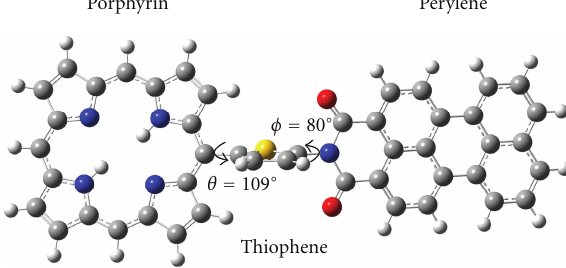
Figure 2: The optimal structure of the PTP compound (R = R (cid:2) = − H), where θ = 109 ◦ and φ = 80 ◦ , obtained from the B3LYP/6– 31G(d)